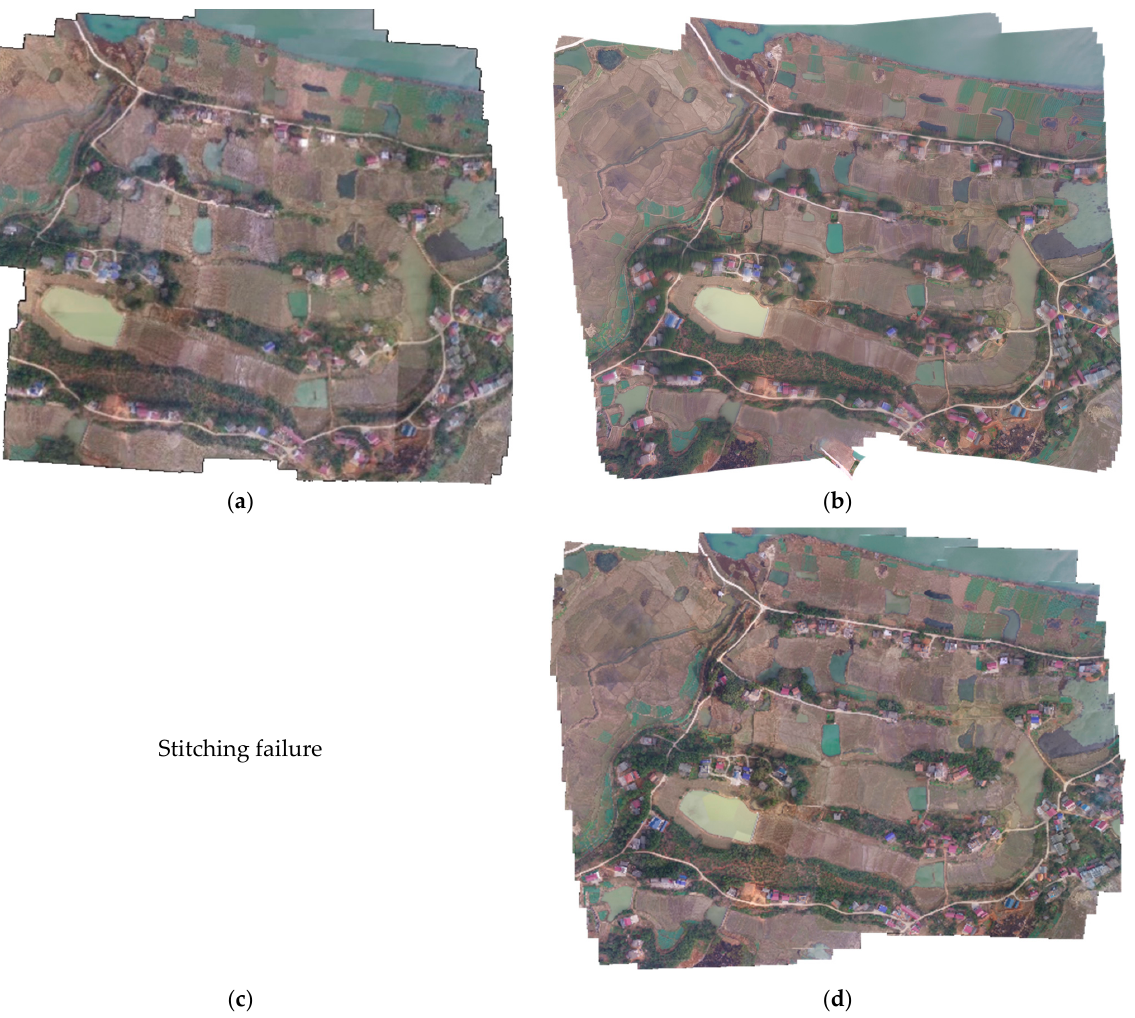
Figure 16. Comparison panorama using different methods. ( a ) QuickBird. ( b ) AutoPano. ( c ) Opencv- Stitcher. ( d ) Our method.